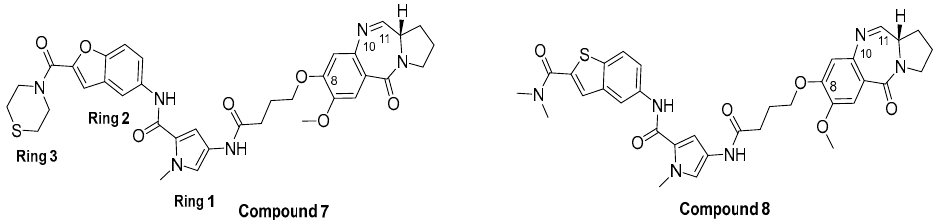
Figure 1. Structure of broad-spectrum C8-linked pyrrolobenzodiazepine compounds 7 and 8